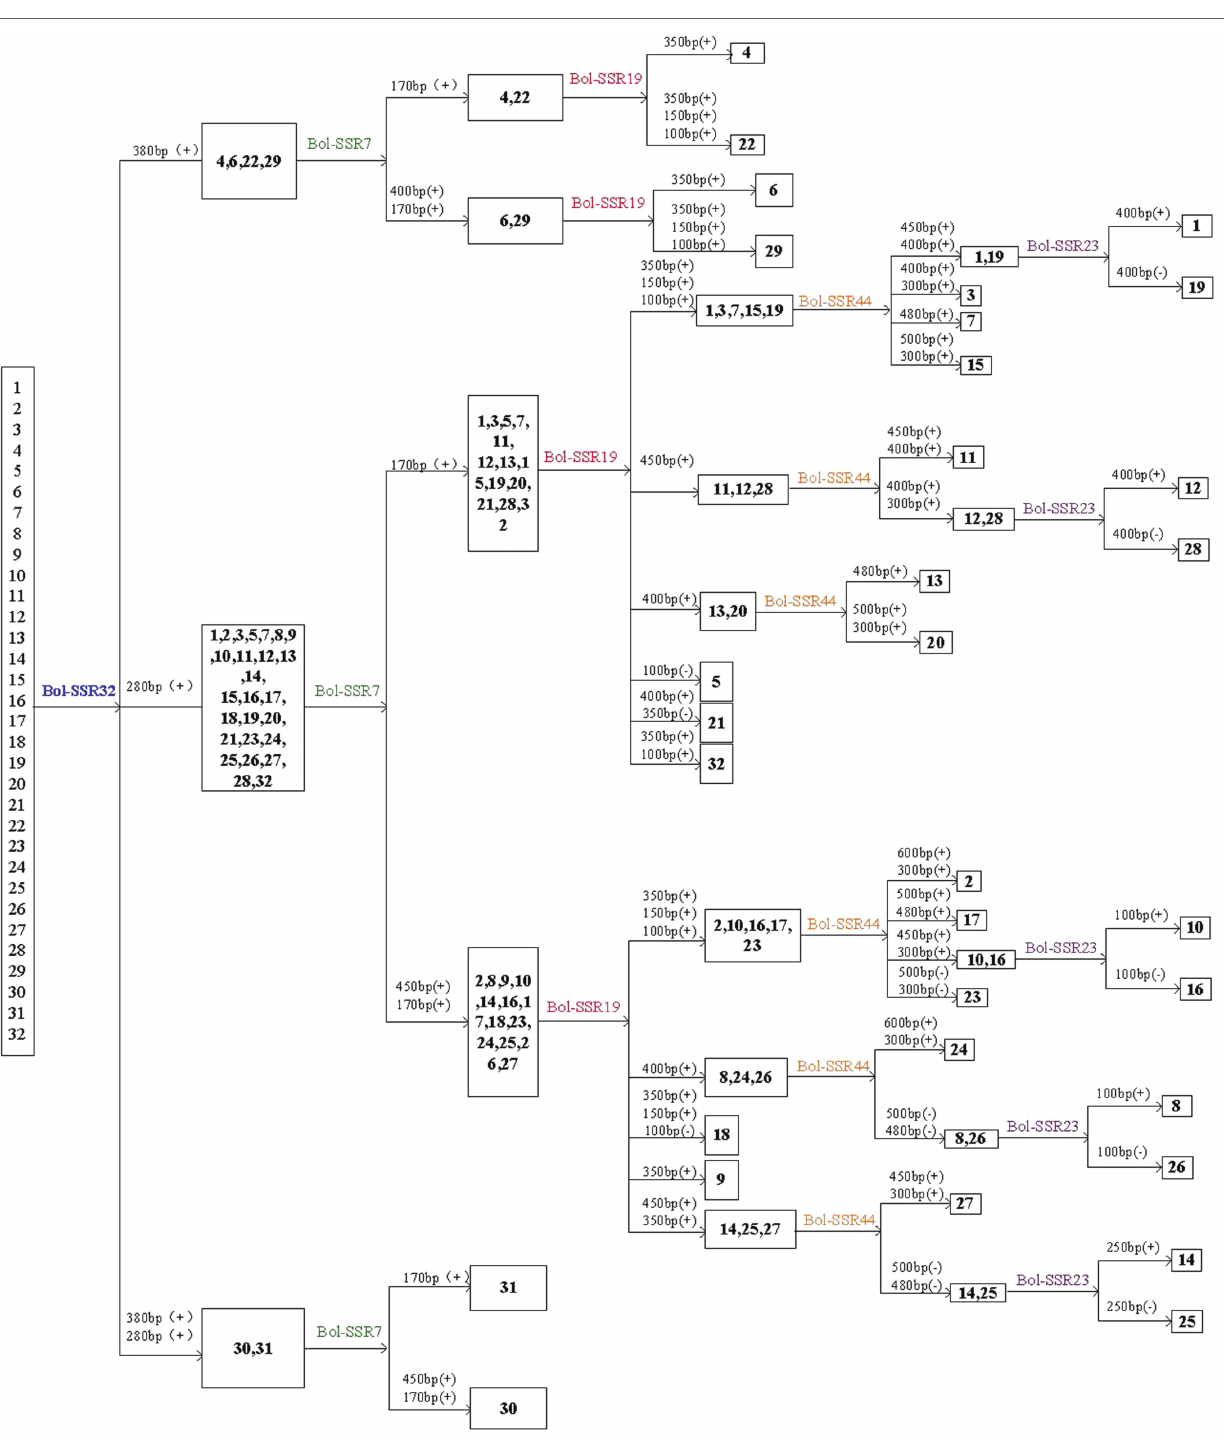
FIGURE 8 | MCID analysis of the 32 cabbage genotypes with the DNA fingerprints of five SSR primers. The number above each horizontal line in the diagram denotes the size of the polymorphic bands used to separate the genotypes following the line. (+) or ( − ) denotes the presence or absence of the polymorphic